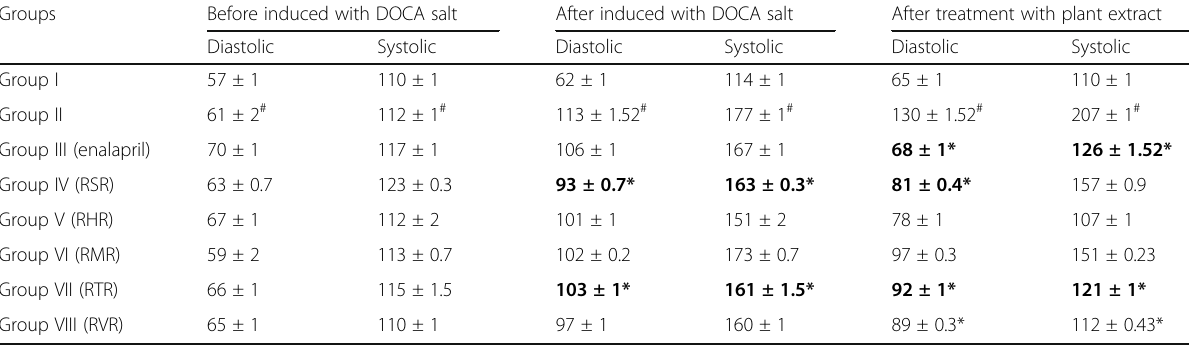
Table 6 Anti-hypertensive activity of various Rauvolfia species Groups Before induced with DOCA salt After induced with DOCA salt After treatment with plant extract